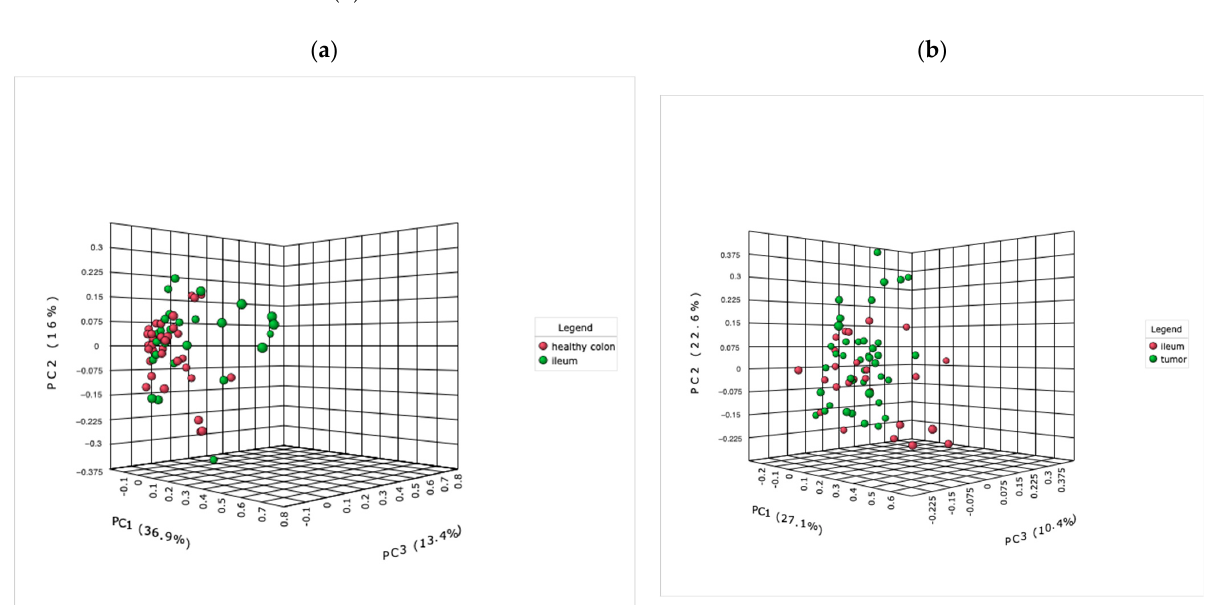
Figure 10. Heatmap of the core microbiome of the terminal ileum (defined as genera present in >50% of samples), based on tumor location: RSCC ( a ) and LSCC ( b ), and on MSS status: MSI ( c ) and MSS ( d ).